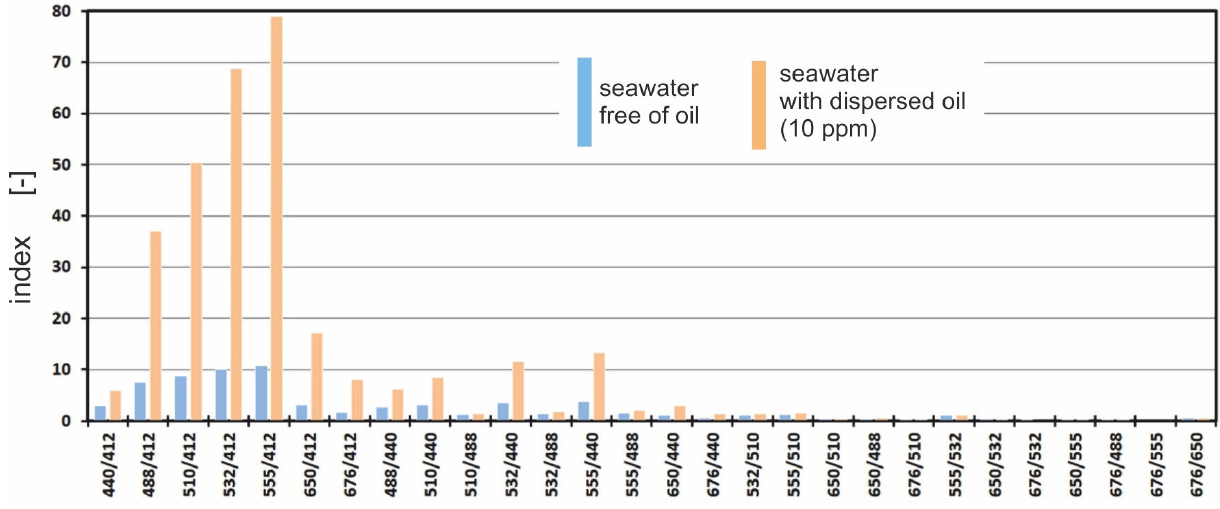
Figure 7 . Spectral indices for both seawater free of oil (blue bar) and seawater polluted with an oil-in-water emulsion (orange bar).